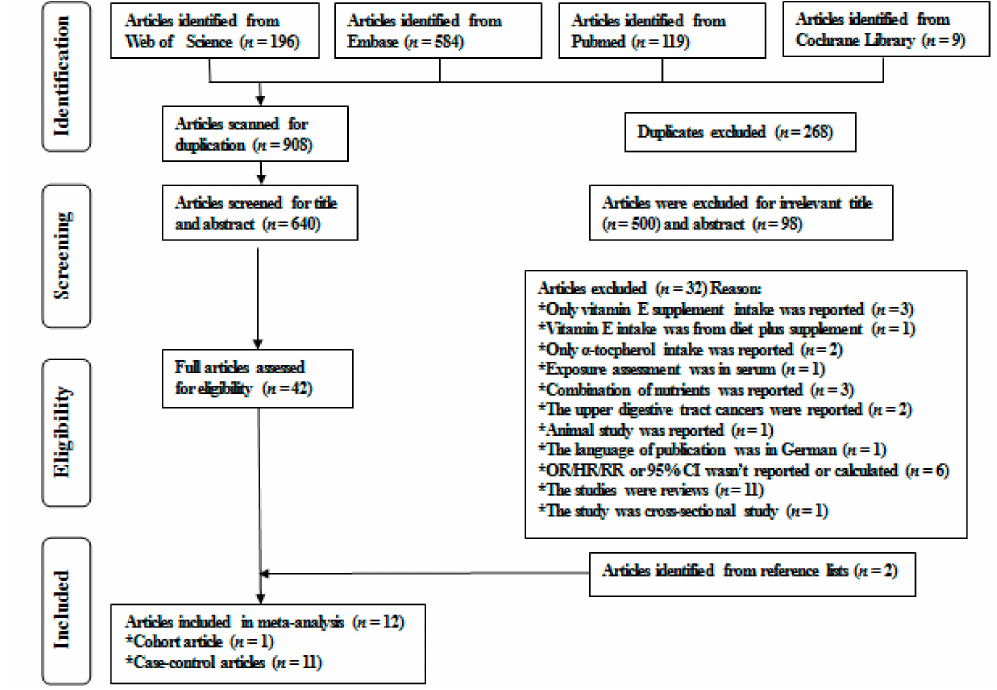
Figure 1. Flow chart of the electronic search for eligible articles. OR: odds ratio; HR: hazard ratio; RR: relative risk; CI: confidence